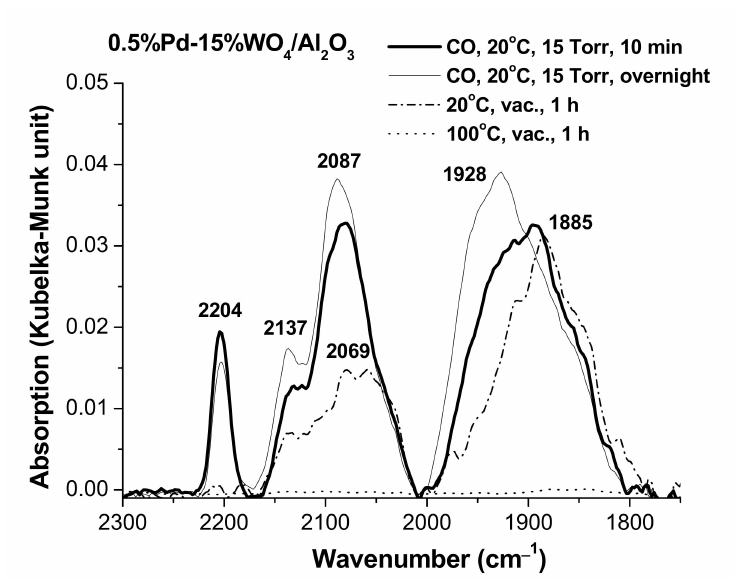
Figure 3. DRIFTS-CO adsorbed on 0.5%Pd-15%H 2 WO 4 /Al 2 O 3